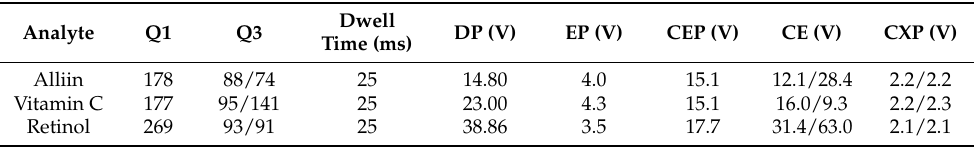
Table 1. The “quantifier” and “qualifier” transitions and the optimal instrumental potential values for Alliin, vitamin C, and